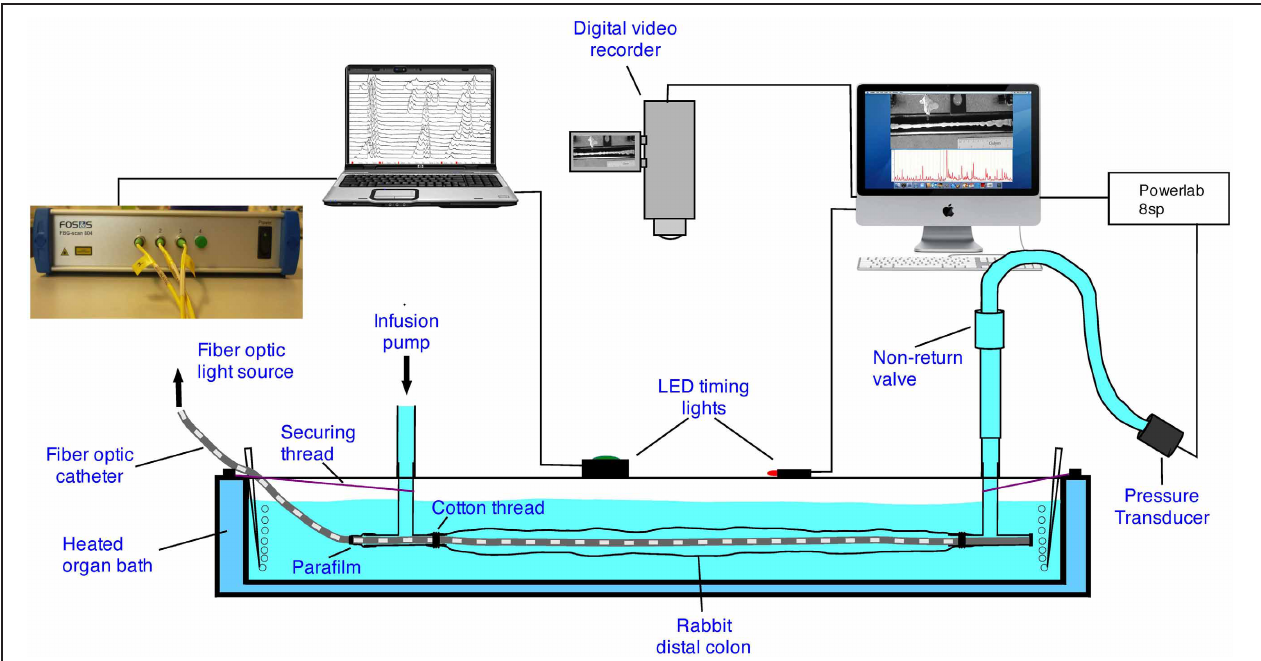
FIGURE 1 | The experimental setup. In some of the preparations the fiber-optic catheter was replaced with an impedance and manometry catheter.